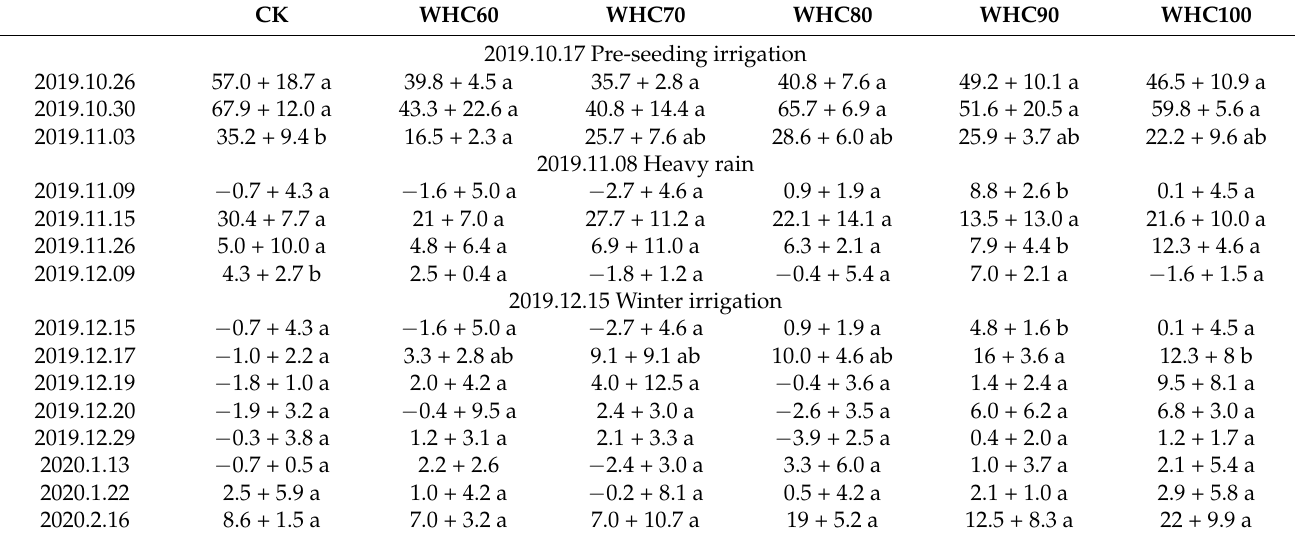
Note: Data is expressed as mean ± standard error form ( n = 3). Values with same letters in the same line are of no significant difference ( p > 0.05), those with different letters are of significant or